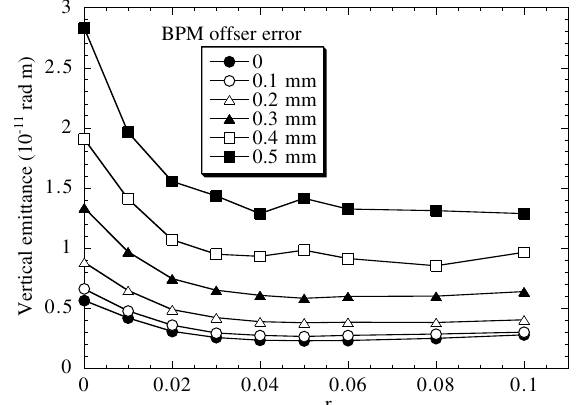
FIG. 9. (cid:26) vs r after coupling correction for different BPM y offset errors. BPM rotation error was set as 0.02 rad.